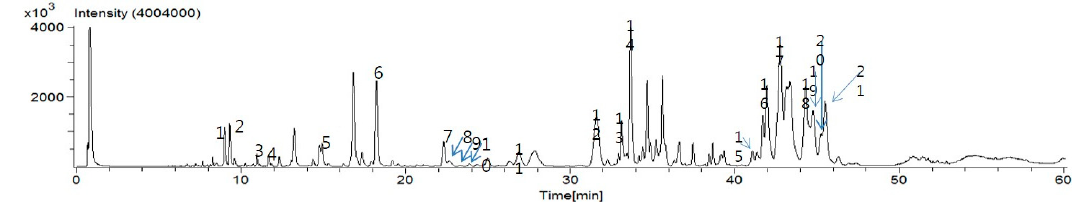
Figure 1. Ultra performance liquid chromatography (UPLC)–electrospray ionization (ESI)–mass spectrometry (MS) base peak chromatograms for compound profiles of Polygala tenuifolia Willd. Table 1. The observed and calculated mass numbers of Ultra performance liquid chromatography (UPLC) peaks of Polygala tenuifolia Radix. Peak